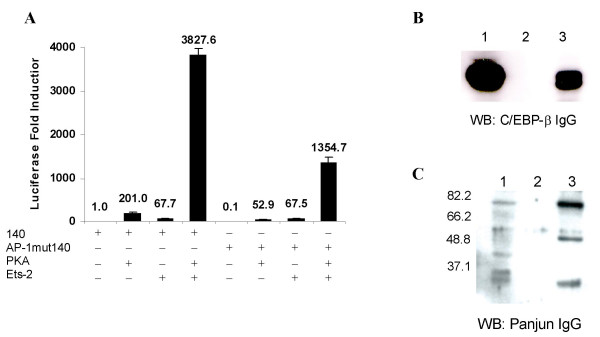
Importance of the AP-1 element (-99 to -93) for the Tkdp-1.140 bp promoter activity in JEG-3 cells. A) Effects of the AP-1 element mutation on the basal, activated PKA, Ets-2 and Ets-2+activated PKA-dependent activation of the 140 bp Tkdp-1 promoter-Luc reporter construct in JEG-3 cells. Luc activities are expressed relative to that of the basal activity of the 140 bp promoter and data are shown as mean ± SEM (n = 3). Following values are significantly different at P < 0.05: 140+PKA vs. AP-1mut140+PKA and 140+Ets-2+PKA vs. AP-1mut140+Ets-2+PKA. B) and C) Pull-down assays with biotinylated AP-1 oligonucleotide (-99 to -93 in the tkdp-1 promoter) and JEG-3 cell extracts(CE). Following pull-down a ssays, WB analysis was performed with B) C/EBP-β IgG and C) pan-Jun IgG. Lane 1: JEG-3 CE (positive control for WB); lane 2: biotinylated AP-1 oligonucleotide; lane 3: JEG-3 CE+biotinylated AP-1 oligonucleotide. The molecular weight standards are shown on the left-hand side.